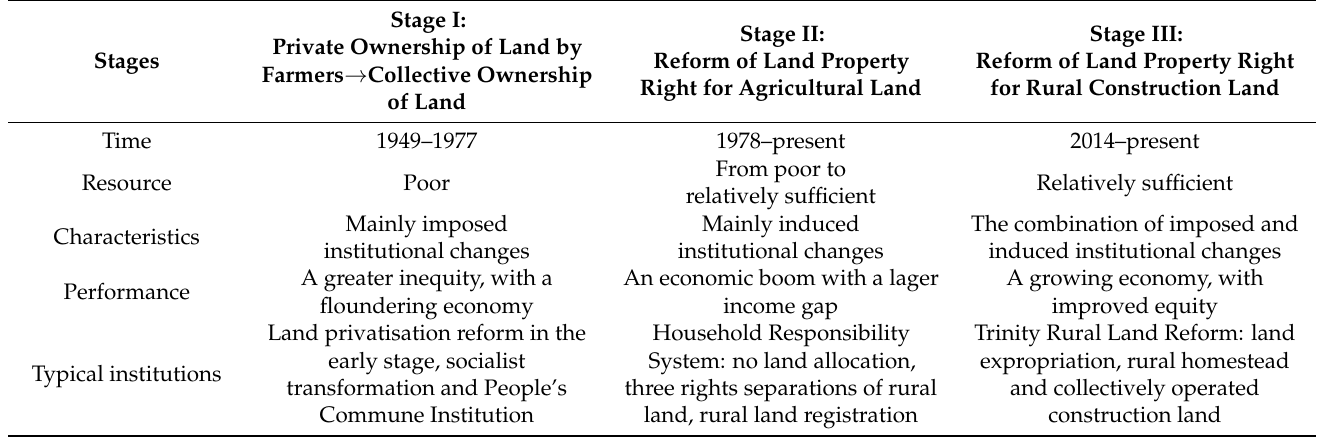
Table 1. Three stages of China’s rural land institutional